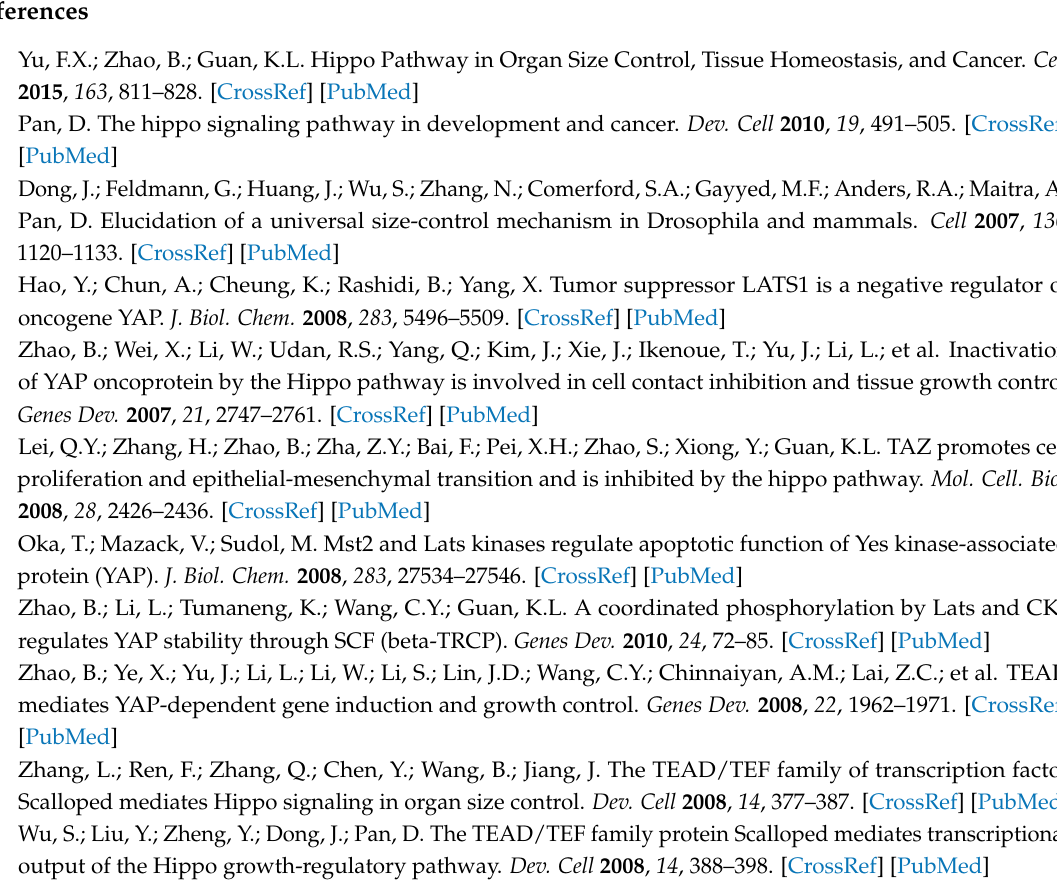
s1, Figure S1: Establishment of YAP reporter cell line, Figure S2: RA-V represses the protein levels of YAP target genes, Figure S3: Mst1/2 double knockout induces liver enlargement, Figure S4: Short-term RA-V treatment did not significantly affect liver/body weight ratio, Table S1: List of Antibodies for WB and IHC Analysis, Table S2: List of primers for qPCR